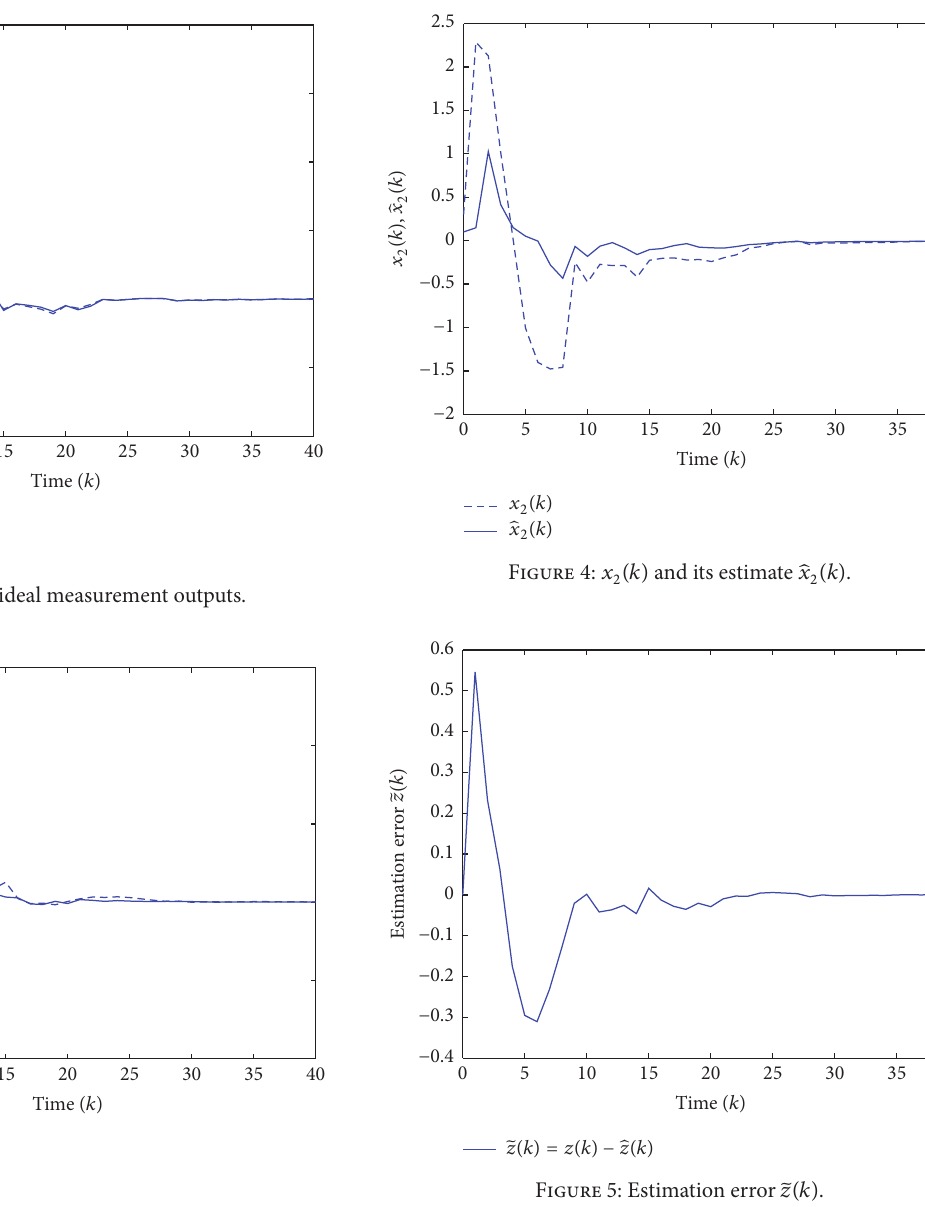
Figure 3: 𝑥 1 (𝑘) and its estimate ̂𝑥 1 (𝑘) .